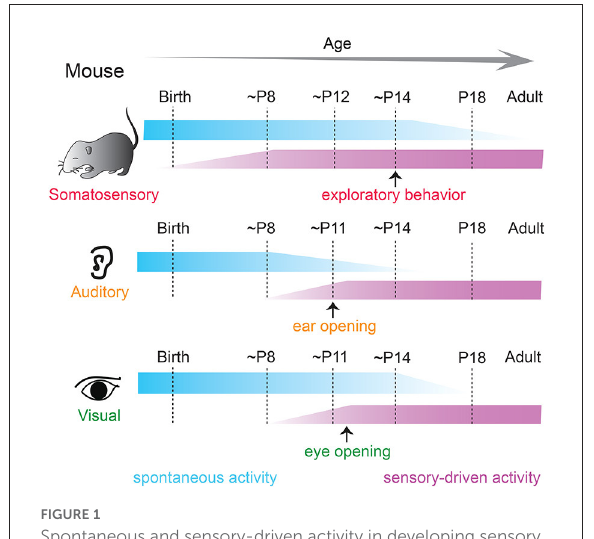
FIGURE1 Spontaneous and sensory-driven activity in developing sensory systems in the mouse. Developmental trajectory of spontaneous (blue) and sensory-driven (magenta) activity in the somatosensory (top) , auditory (middle) , and visual (bottom) systems in the mouse. Sensory-evoked activity is observed before the onset of active sensory experience in all modalities. P, postnatal